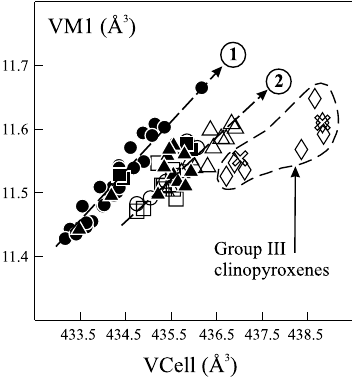
Fig. 5 – Variation of VCell vs. VM1 for clinopyroxenes from the Jan- jão, Pandolfo and Lambedor diatremes. 1 and 2: trend of clinopyrox- enes that are thought to have been equilibrated in a mantle assemblage where garnet was not present and with garnet, respectively. Symbols as in Fig.